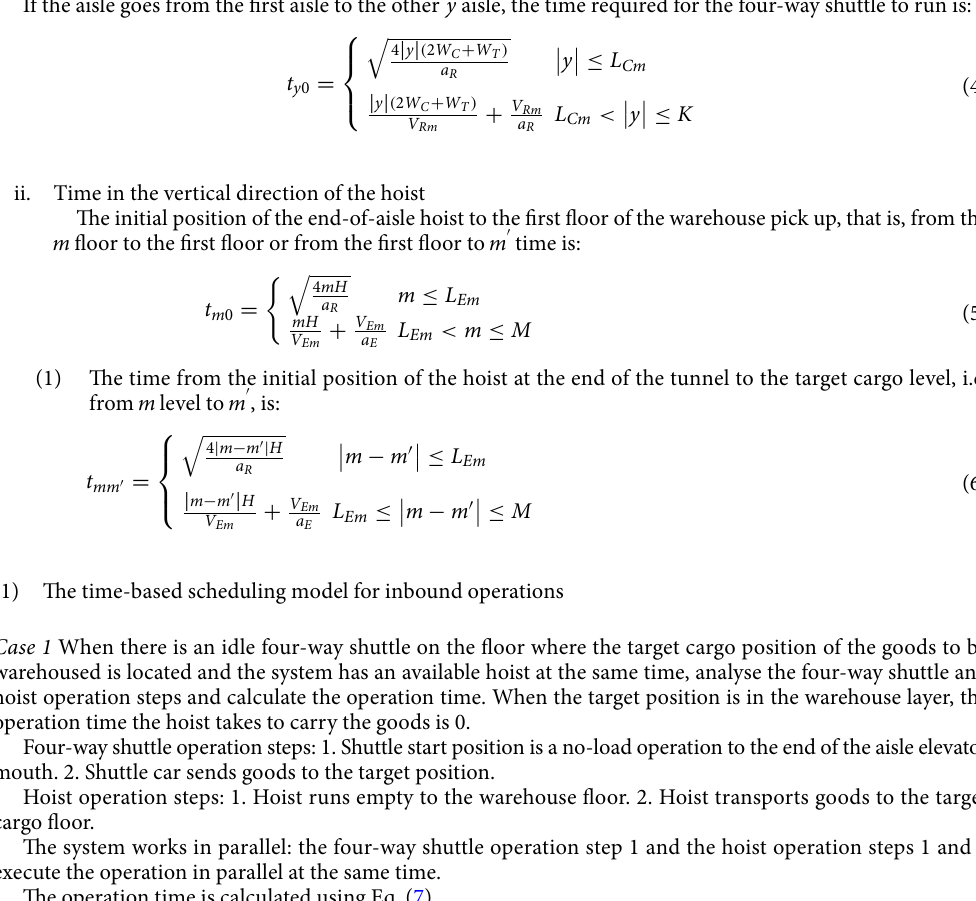
The system works in parallel: the four-way shuttle operation step 1 and the hoist operation steps 1 and 2 execute the operation in parallel at the same time. The operation time is calculated using Eq.